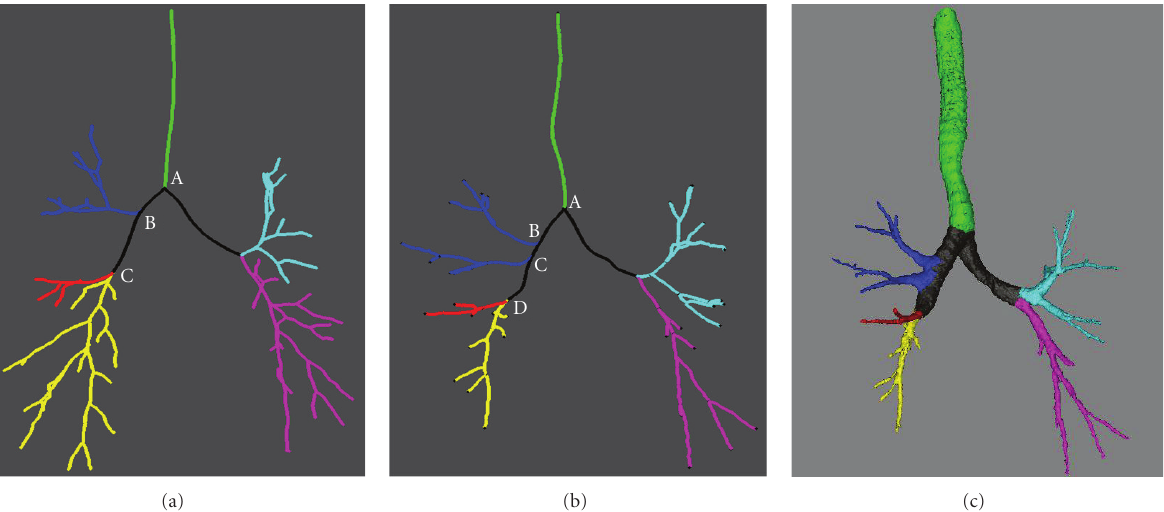
Figure 5: A normal example and an abnormal example. (a) An example with normal topology, (b) an example with abnormal topology, (c) 3D view of the abnormal